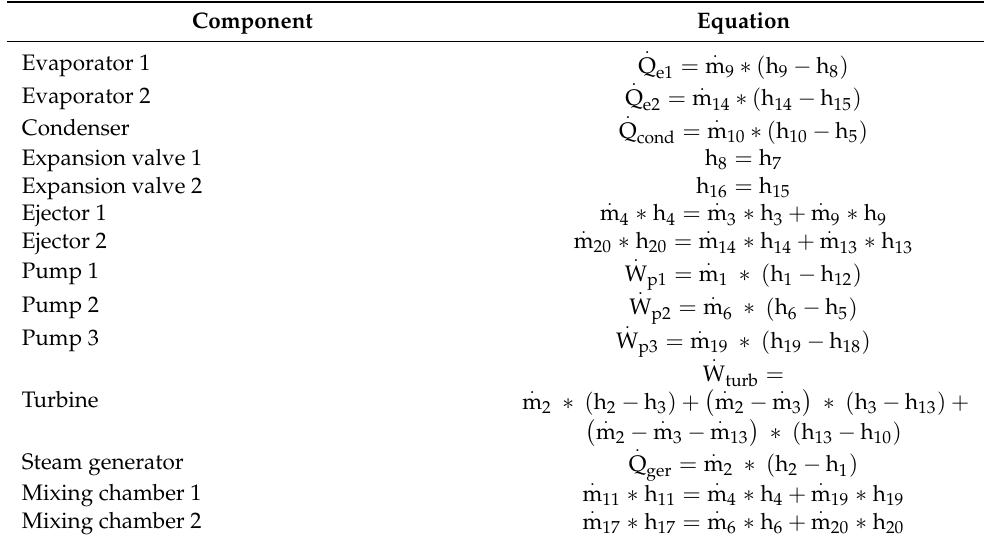
Table 1. Energy balances for the system